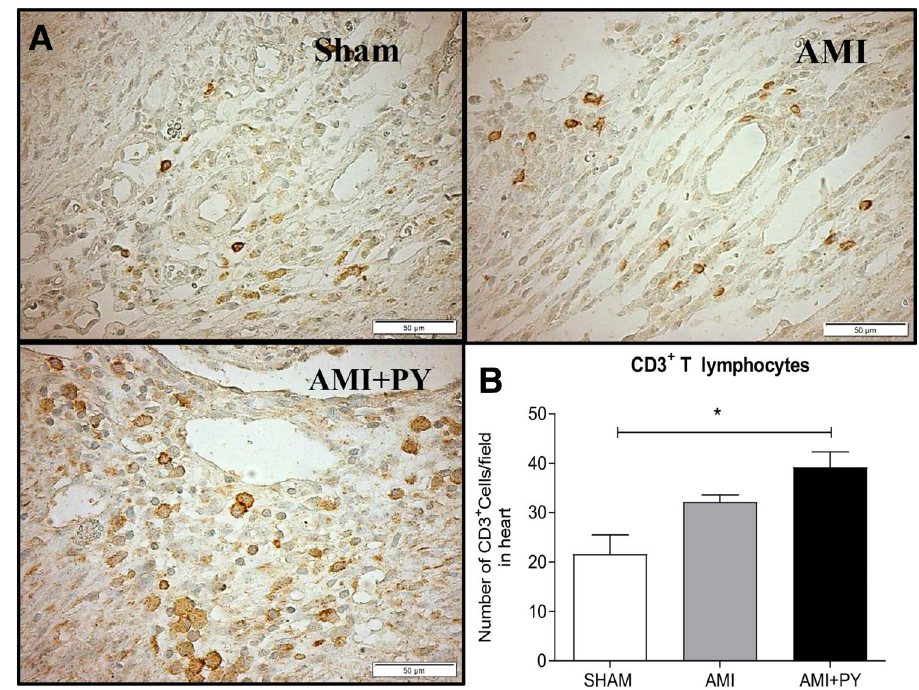
Figure 6. CD3 + cell count (Total lymphocytes) ( A ) Photomicrographs showing the Total lymphocytes within the infarcted zone from the left ventricle (magnification 400×) and ( B ) bar graphs of CD3 + lymphocytes positive cells in each group was compared. Fifteen microscopic fields of the infarcted and peri-infarcted zones were analyzed (5–6 animals per group). * P < 0.05 statistically significant. * AMI + PY vs Sham. (Immunohistochemistry, diaminobenzidine: scale bar equals 50 µm). Values expressed as mean ± SEM. Statistical significance was determined by one-way ANOVA followed by a multiple comparisons test Tukey’s was performed using GraphPad Prism version 9.0.1. www. graph pad.